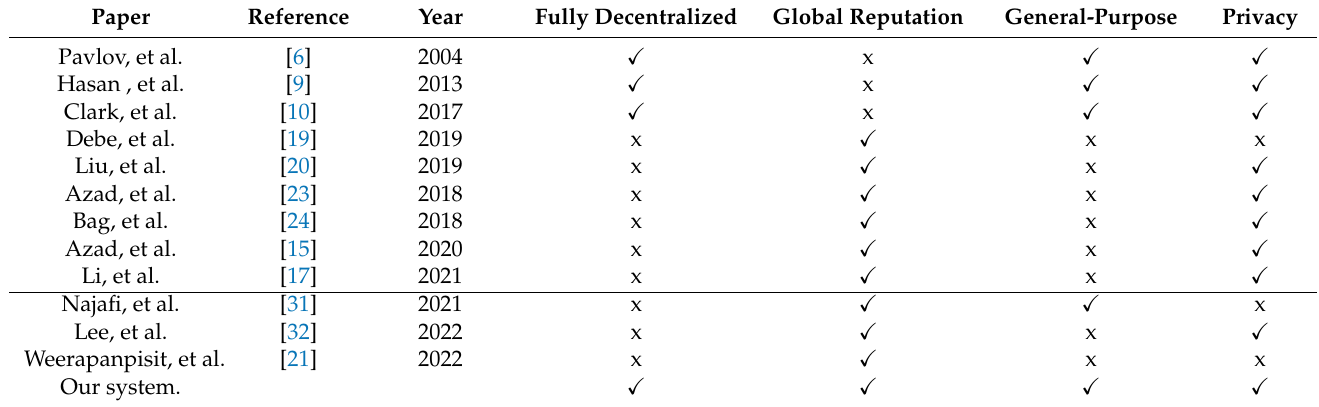
Table 1. A Comparative study of privacy-preserving decentralized reputation